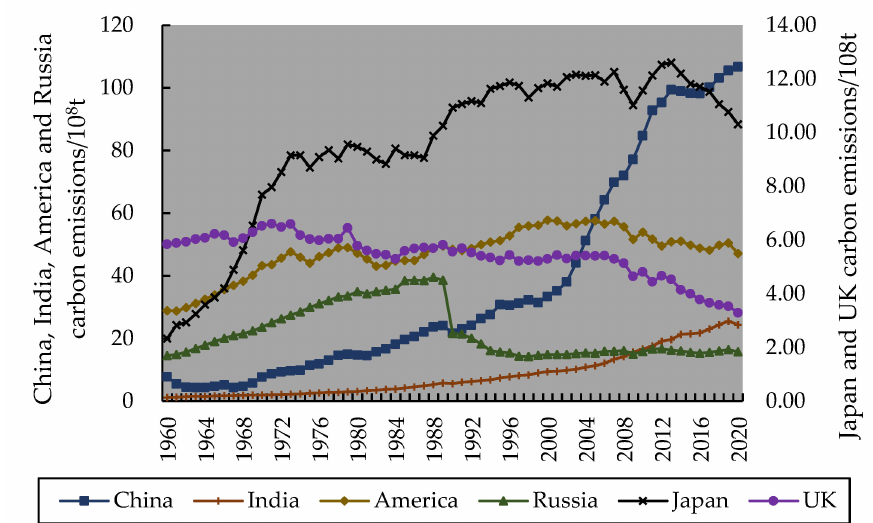
Figure 1. Carbon dioxide emissions in various regions of the world from 1960 to 2020.